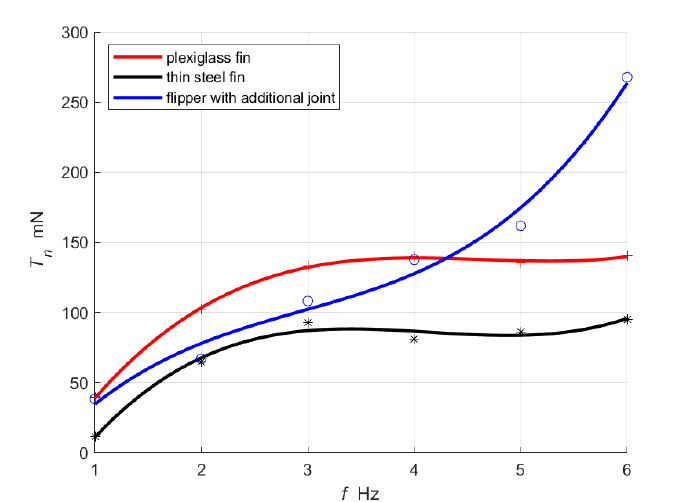
Figure 11. The mean thrust generated by fins for different frequencies and fluid velocity u = 0 m/s.